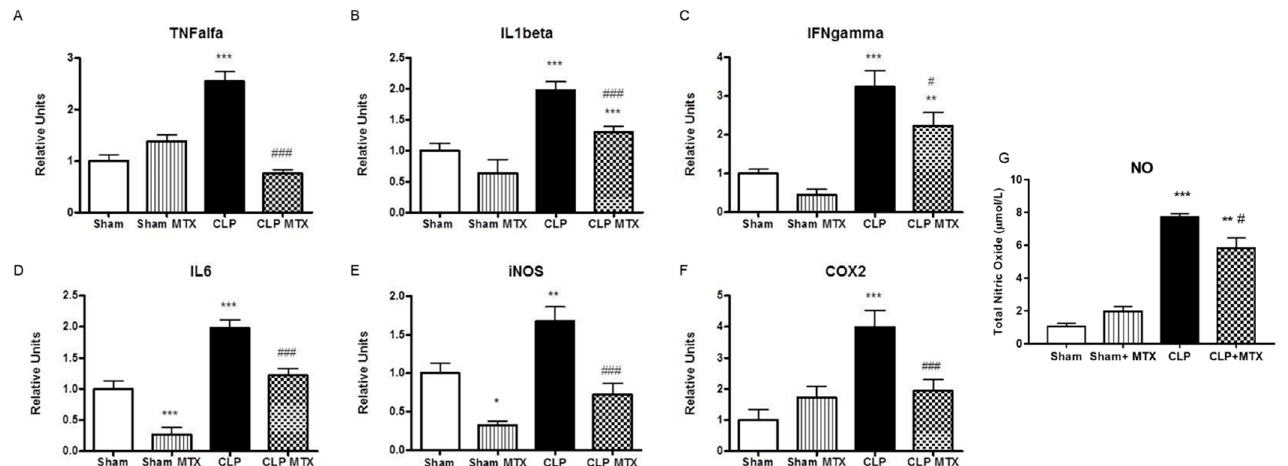
Figure 4. Gene expression of pro-inflammatory markers in lung tissue and total nitric oxide in bronchoalveolar lavage. ( A ) to ( F ): mRNA expression by qPCR. Data are expressed mean ± SEM, ∆ Ct correction was applied using GAPDH as a housekeeping gene and units are relative to the expression of control group. Sham and Sham + MTX n = 10; CLP and CLP + MTX n = 15. ( G ) Nitric oxide measured in bronchoalveolar lavage. Sham and Sham + MTX n = 5; CLP and CLP + MTX n = 6. * p < 0.05 vs. Sham group; # p < 0.05 vs. CLP group. ** p < 0.01; ***/### p < 0.001.